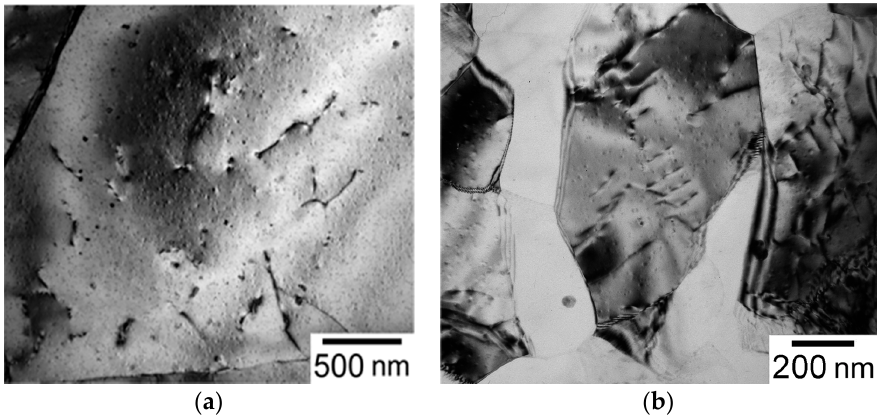
Figure 1. Initial microstructure of the 5024 alloy: ( a ) coarse-grained state; ( b ) after 12 equal-channel angular pressing (ECAP) passes.